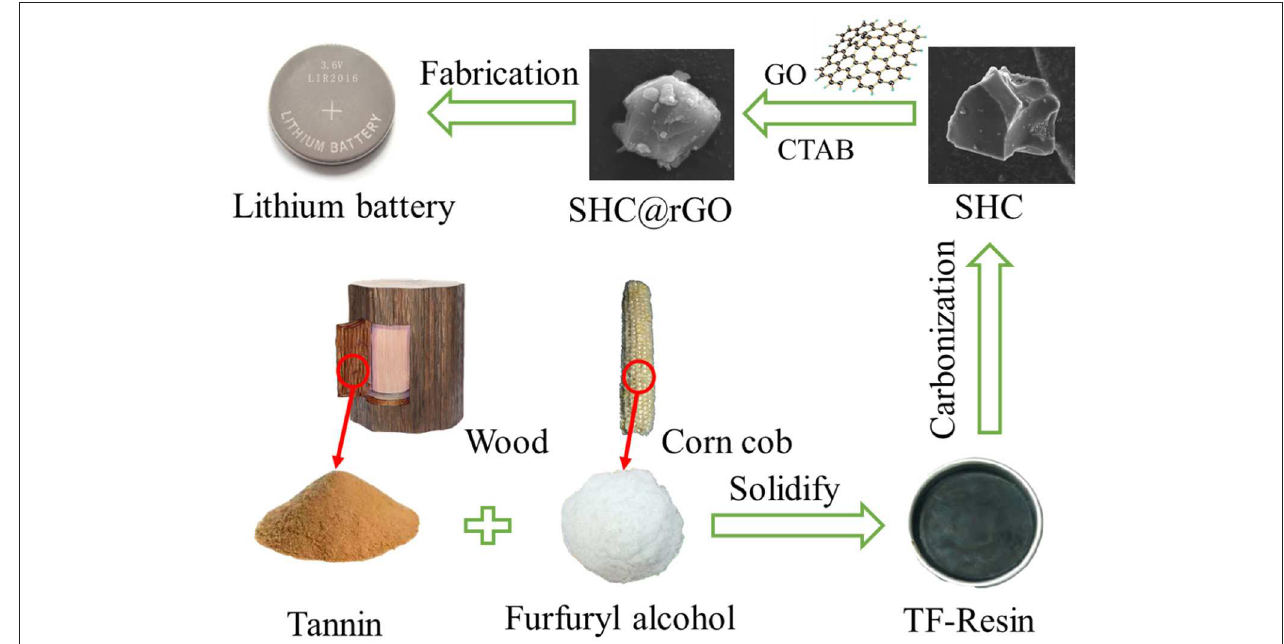
FIGURE 1 | Schematic illustration of the preparation of SHC and SHC@rGO.